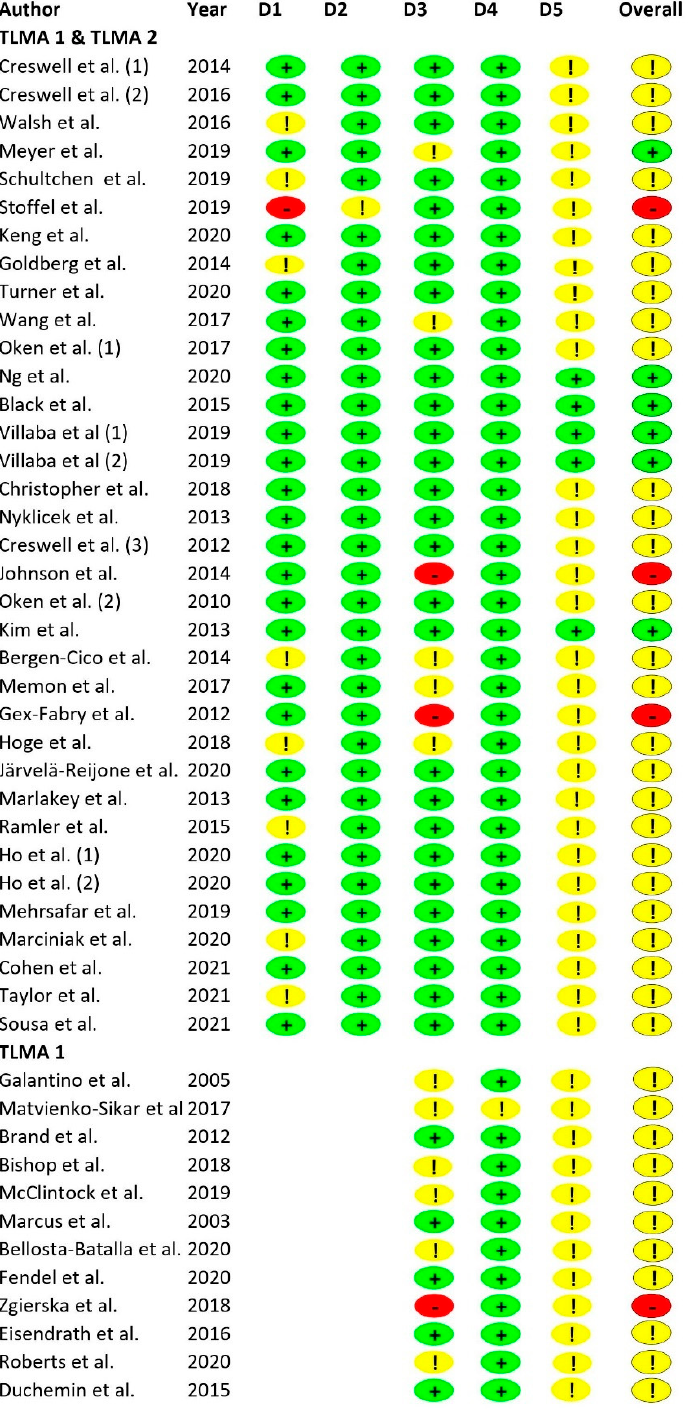
Figure 2. Results of the Risk of Bias Assessment (RoB 2). Note. References of included studies are provided in Table 2. Numbers in parentheses refer to different samples of the respective studies (see Table 2 for details). TLMA = three-level meta-analysis; + = low risk; ! = some concerns; - = high risk; D1 = randomization process; D2 = deviations from intended interventions; D3 = missing outcome data; D4 = measurement of the outcome; D5 = selection of reported result.